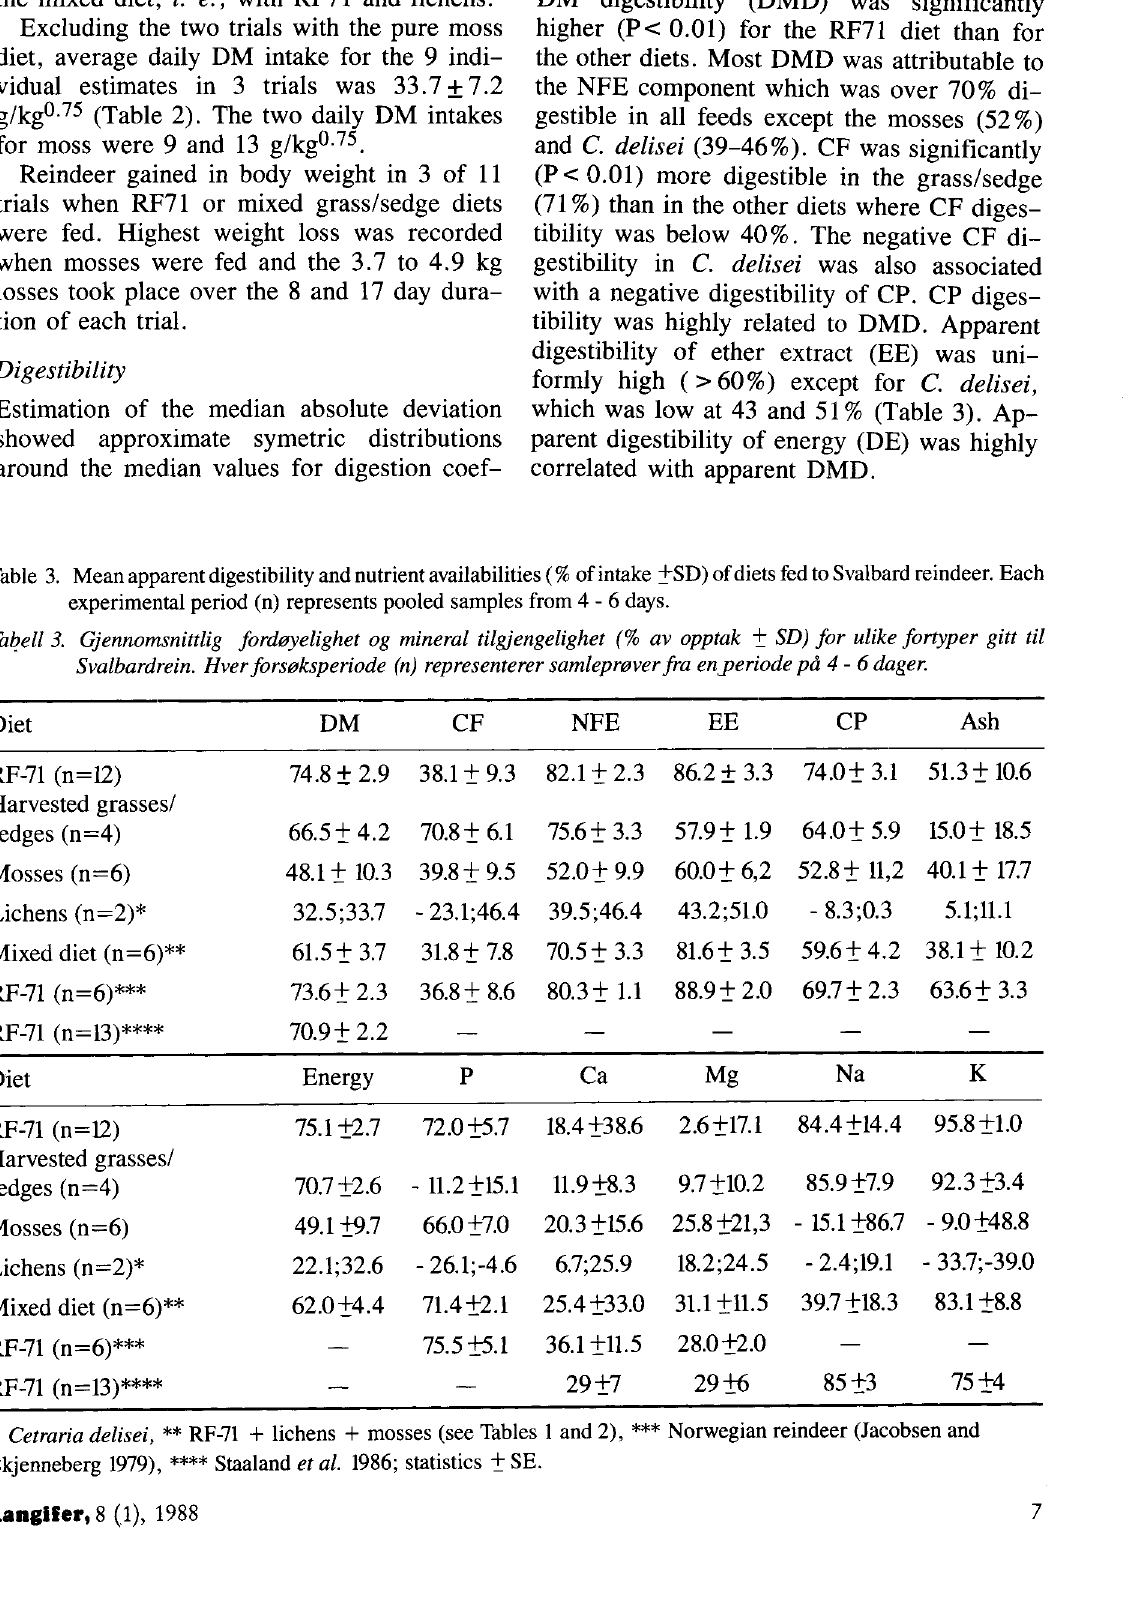
Table 3. Mean apparent digestibility and nutrient availabilities (% of intake +SD) of diets fed to Svalbard reindeer. Each experimental period (n) represents pooled samples from 4-6 days. Tabell 3. Gjennomsnittlig fordøyelighet og mineral tilgjengelighet (% av opptak + SD) for ulike fortyper gitt til Svalbardrein. Hver forsøksperiode (n) representerer samleprøver fra en periode på 4 - 6